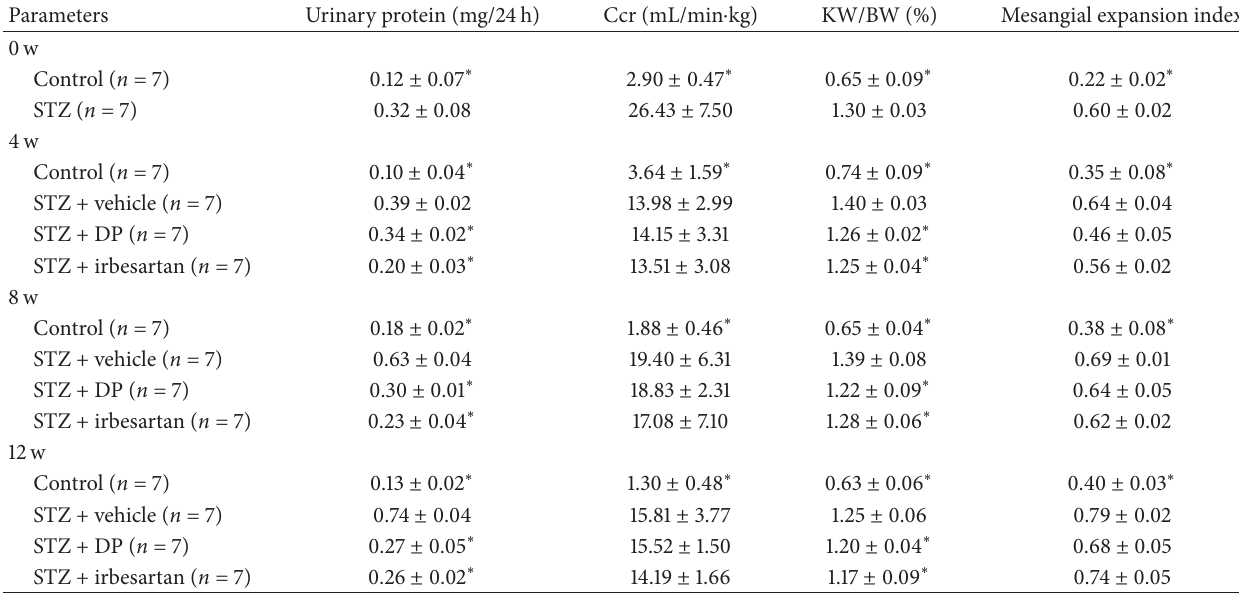
Table 3: Renal functional detection and pathological changes of STZ-induced diabetes and treatments in